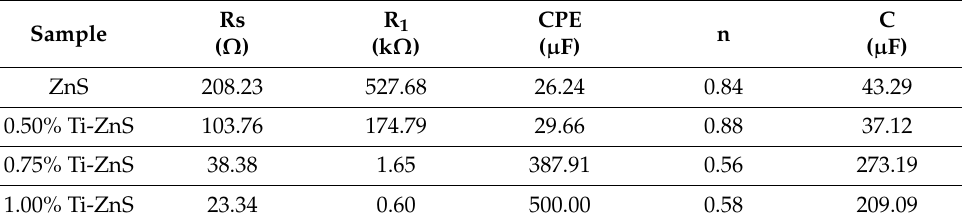
Figure 9. EIS equivalent circuit of the undoped and Ti-doped ZnS. Table 3. EIS parameters determined from the equivalent circuit.